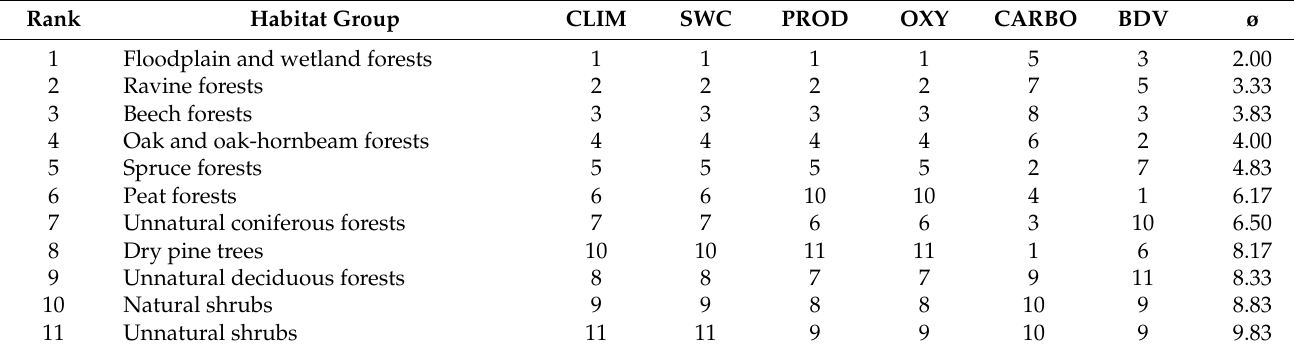
Table 5. Ranking of forest habitats, by importance in ecosystem function provision related to area unit. Rank